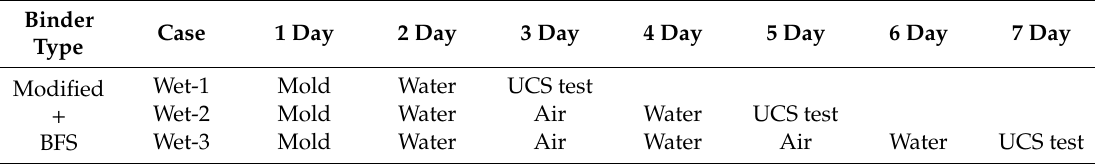
Table 9. The curing condition of the repeated soaking test.